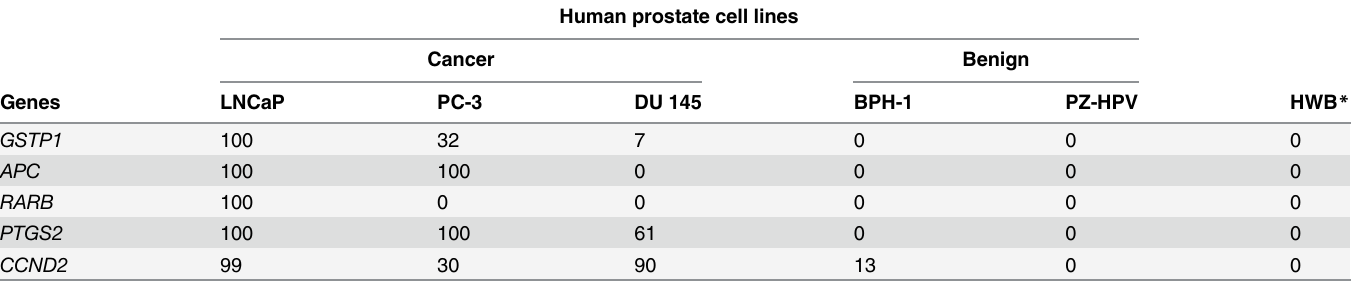
Table 2. DNA methylation of the five marker genes in human prostate cell lines and whole